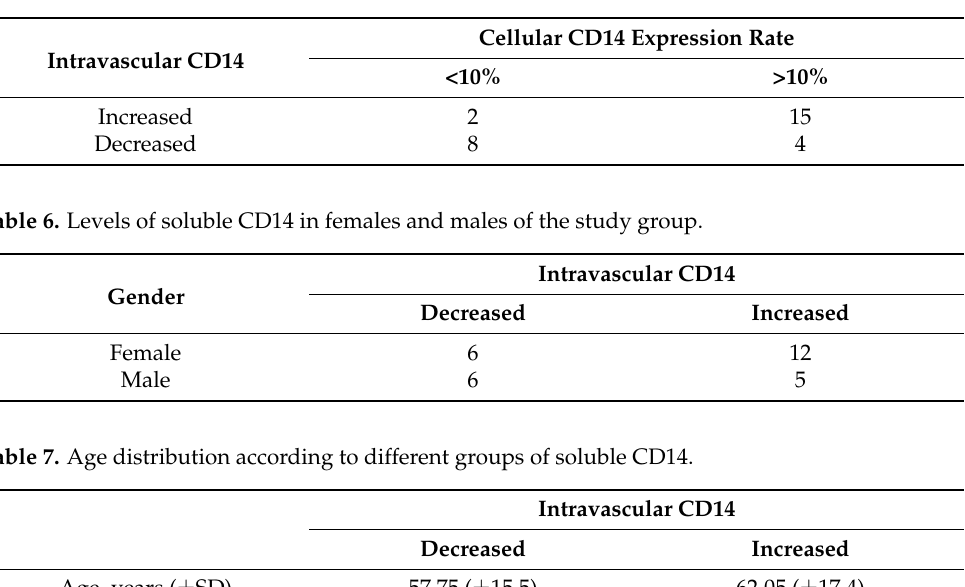
Table 5. Comparison between different levels of membranous and soluble CD14 in the study group.